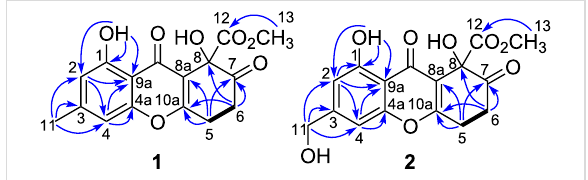
Figure 2: Key HMBC (blue arrows) and COSY (bold bonds) correla- tions in 1 and 2